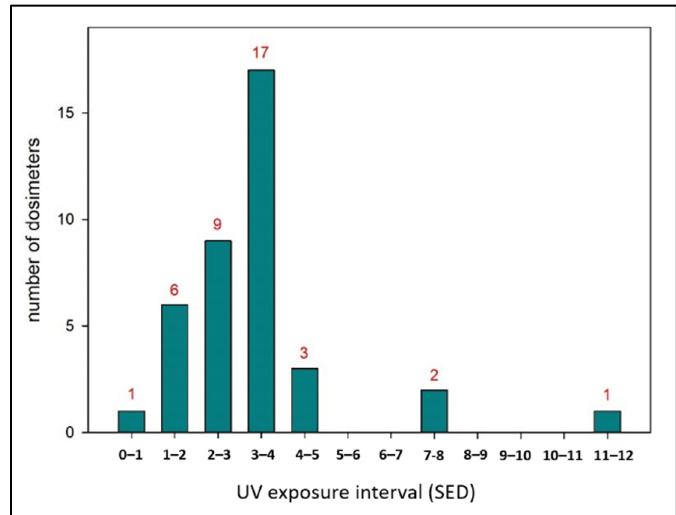
Figure 3. Histogram of individual UV exposure in units of Standard Erythema Dose (SED) measured within the framework of a company party by electronic dosimeters of type X2012-10. Red numbers indicate the number of dosimeters (results) for each exposure interval. Number of participants: 39; mean value: 3.4 SED; standard deviation: 1.9 SED; maximum value 11.1 SED; minimum value: 0.6 SED; global irradiation: 25.6 SED.